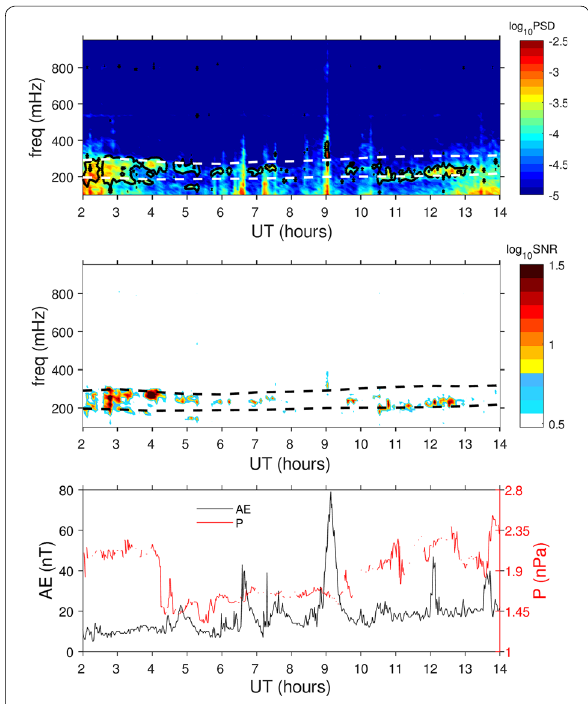
Fig. 1 The dynamical spectrum (top panel) and SNR ( f ) (middle panel) of the horizontal magnetic field at MZS on 22 February 2007 between 0200 and 1400 UT, compared with the simultaneous AE index (blue line) and solar wind pressure P (red line) (bottom panel). Black contours in the dynamical spectrum indicate SNR ( f ) >